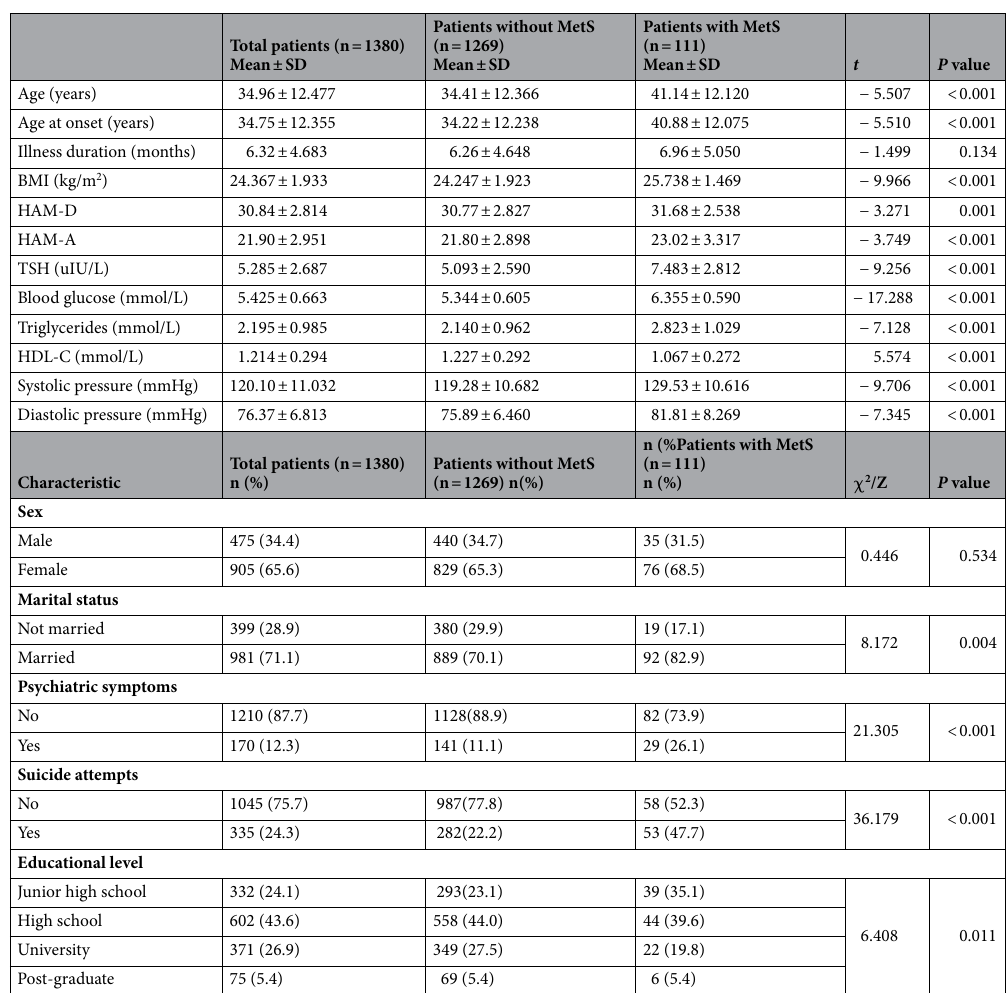
Table 1. Sociodemographic and clinical characteristics of AMD patients with and without MetS. BMI body mass index, HAM-D Hamilton depression rating scale, HAM-A Hamilton anxiety rating scale, TSH thyrotropin, thyroid-stimulating hormone, HDL-C high-density lipoprotein